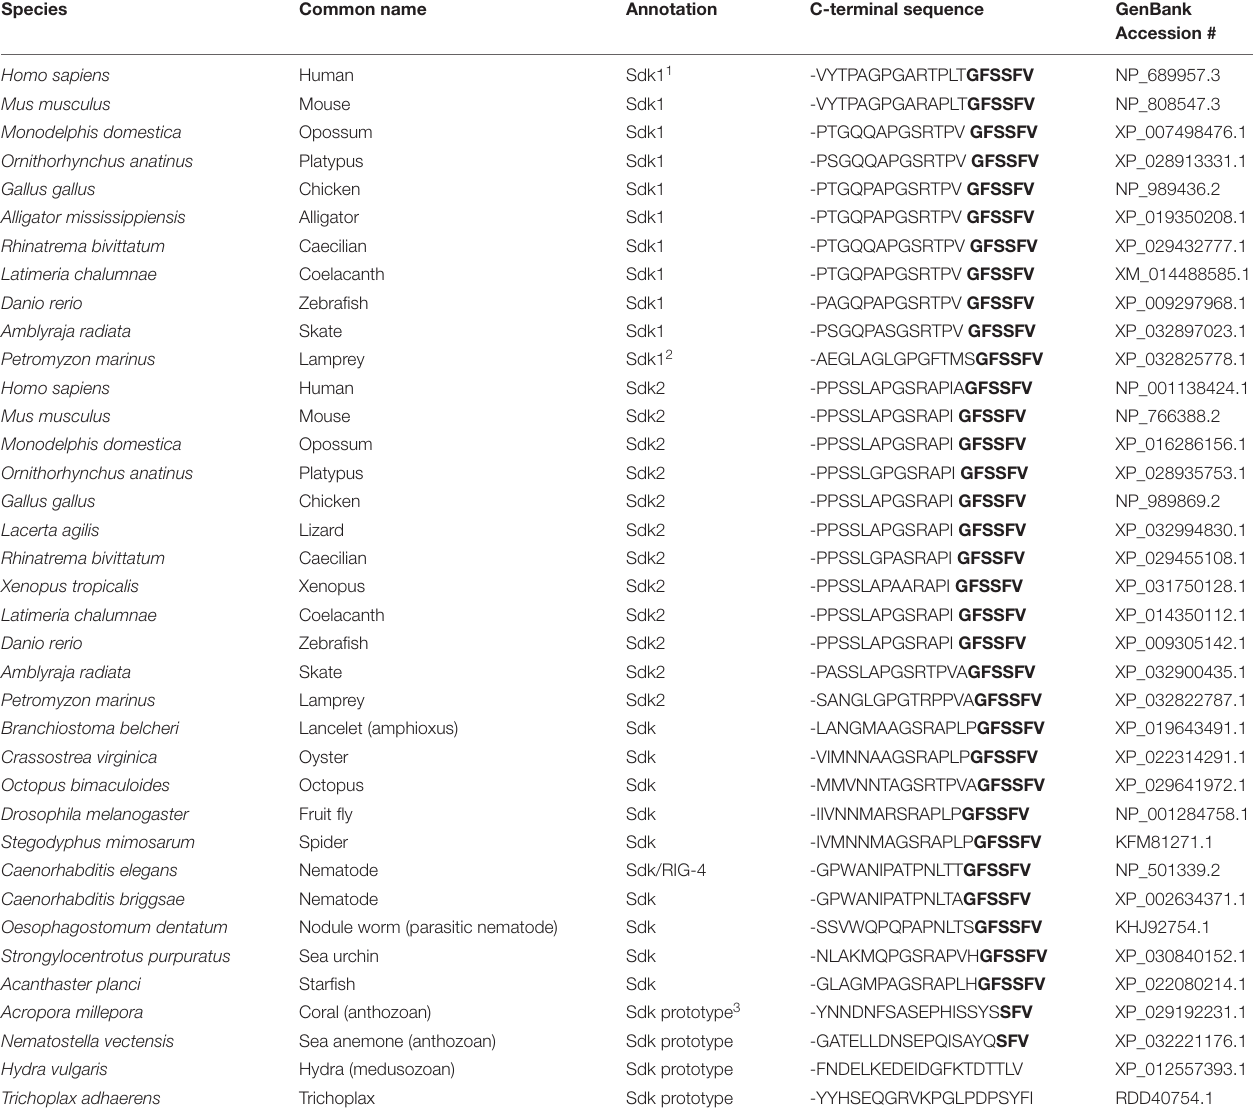
TABLE 1 | Sdk1, Sdk2, Sdk, and Sdk